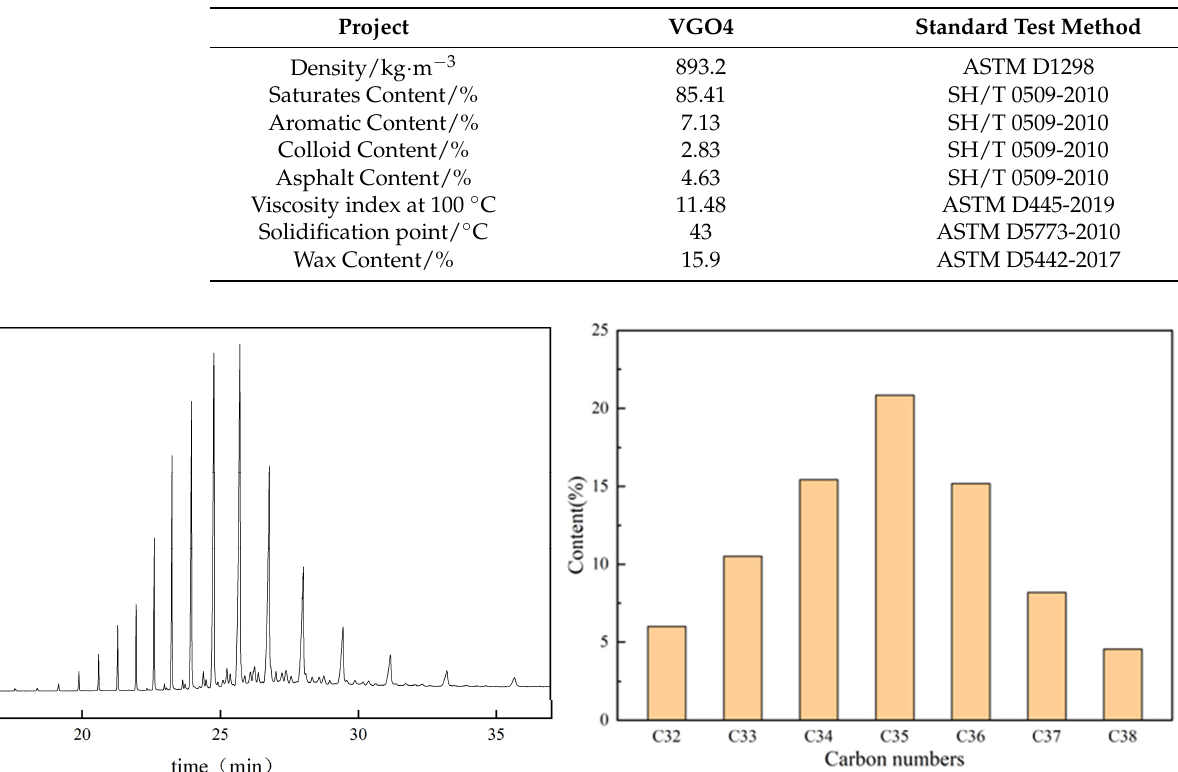
Figure 1. Pyrolysis gas chromatogram and carbon number distribution of paraffin in VGO4.